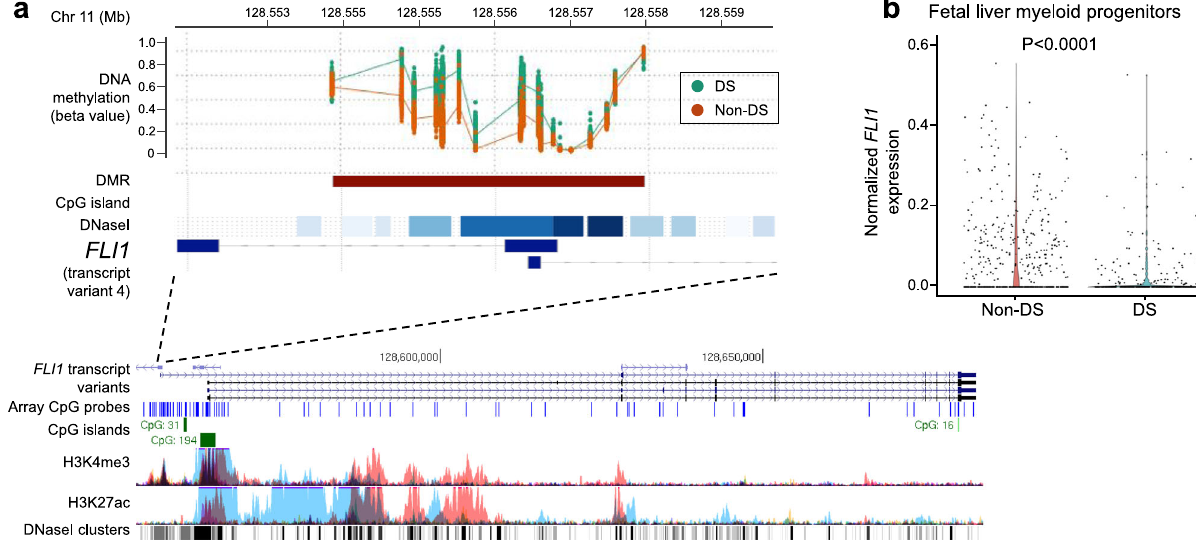
Fig. 5 Down syndrome (DS)-associated differentially methylated region (DMR) overlapping FLI1 promoter region. a DS-associated DMR ( Š idák- corrected P = 1.65× 10 − 78 from comb-p), which included 19 CpGs, had a mean Δ β -value = + 0.132 between DS (teal, N = 196) and non-DS (red, N = 439) newborns, and overlapped a promoter of FLI1 transcript variant 4. The position of the DMR (brown horizontal bar) is shown relative to the FLI1 gene in the UCSC Genome Browser (https://genome.ucsc.edu/), along with tracks for chromatin accessibility (DNase I clusters, darkness corresponds to signal strength) and histone modi fi cations (H3K4me3, H3K27ac), CpG islands (green), and a custom track displaying positions of the array CpG probes (blue). b Violin plot showing normalized FLI1 expression derived from single-cell qRT-PCR on index-sorted FL myeloid progenitors with megakaryocyte – erythroid potential (Lin − CD34 + CD38 + CD45RA − ) from non-DS ( N = 3) and DS ( N = 3) subjects. FLI1 expression was signi fi cantly reduced in DS myeloid progenitor cells ( N = 292) compared with non-DS cells ( N = 412) ( P = 2.20 × 10 − 16 , two-sided Wilcoxon rank-sum test). Horizontal lines represent the median.